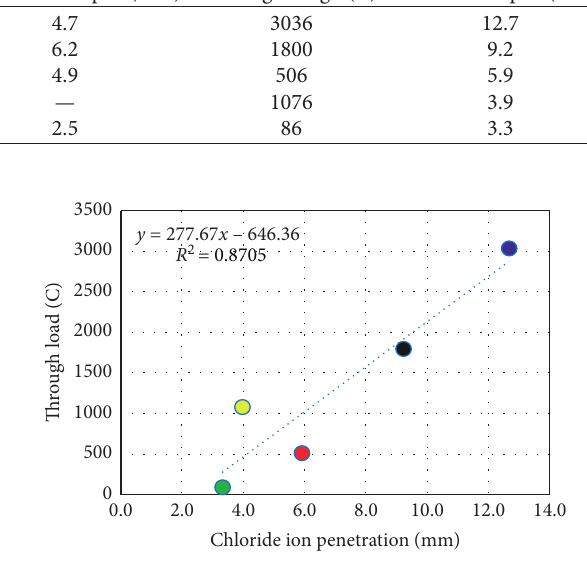
Figure 9: Linear regression analysis between the parameters of through load and depth of penetration of chloride ions.